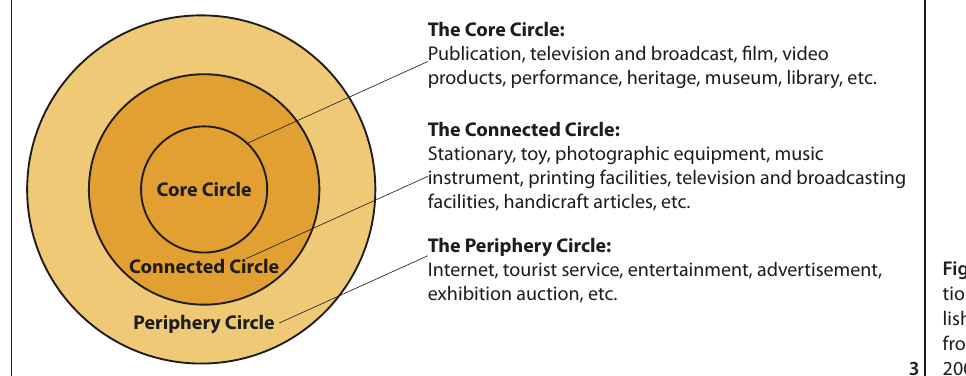
Figure 3 The Chinese classifica- tion of cultural industries pub- lished in 2004 (Source: adopted from National Statistics Bureau 2004).